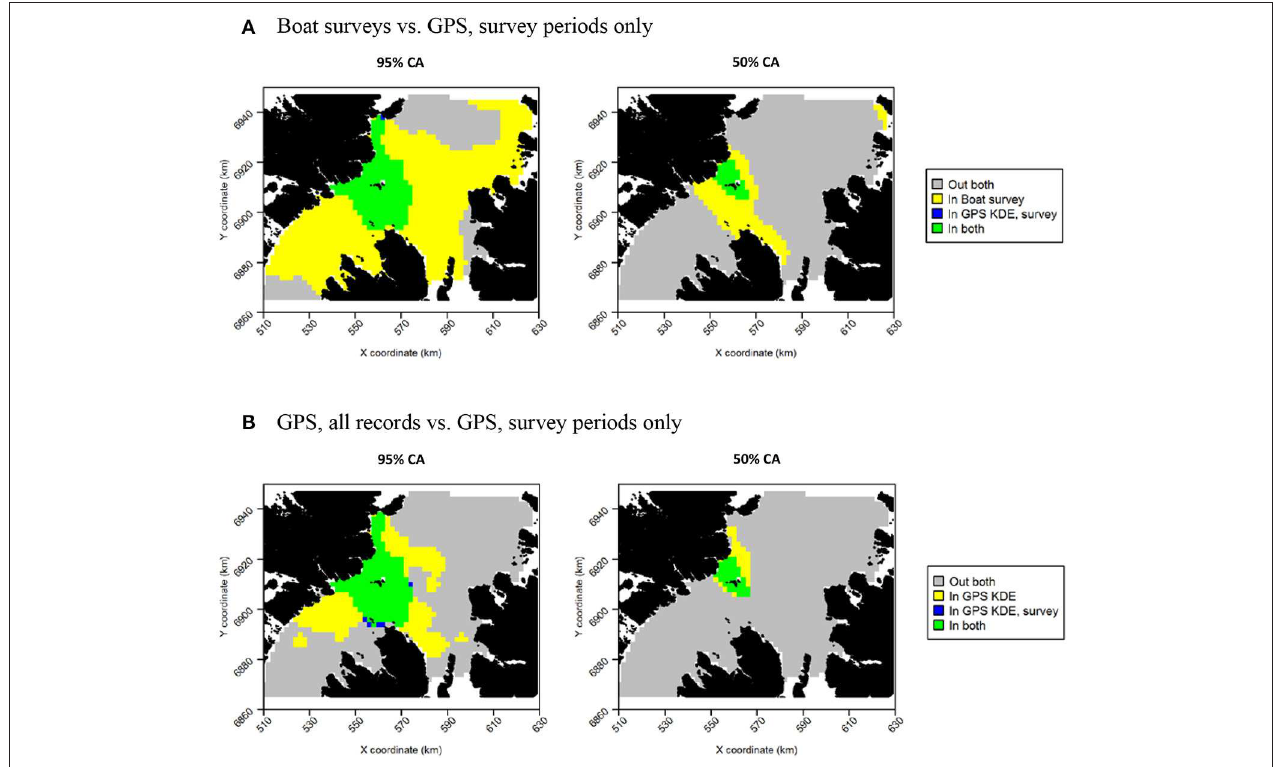
FIGURE 13 | Overlap between razorbill core areas (CAs) derived from boat surveys, GPS tracking during boat survey periods only and all GPS tracking data. In all maps, gray indicates areas outside of the CA in both data sources, and green indicates areas inside the CA in both data sources; blue and yellow indicate areas in the CA in one data source but not the other. (A) Boat surveys vs. GPS, survey periods only. (B) GPS, all records vs. GPS, survey periods